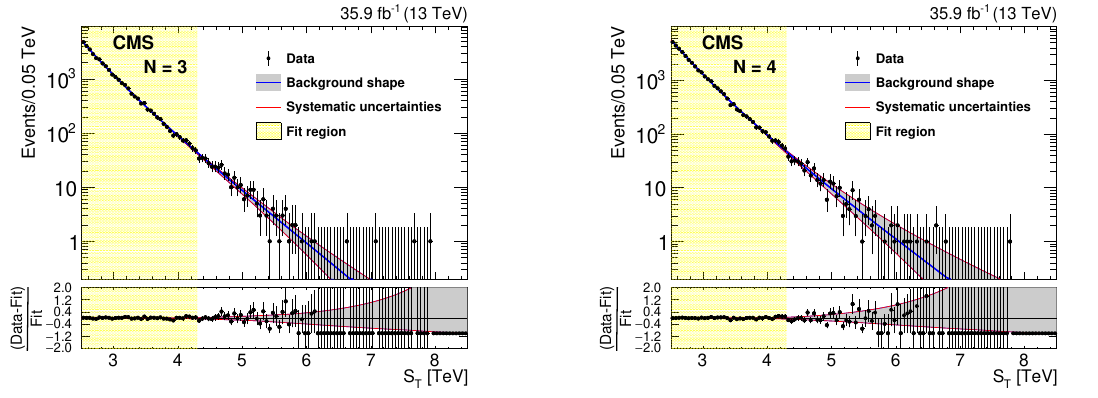
Figure 3 . The results of the (cid:12)t to data with N = 3 (left) and N = 4 (right), after discarding the functions that fail to monotonically decrease up to S T = 13 TeV. The description of the best (cid:12)t function and the envelope are given in the main text. A few points beyond the plotted vertical range in the ratio panels are outside the (cid:12)t region and do not contribute to the (cid:12)t